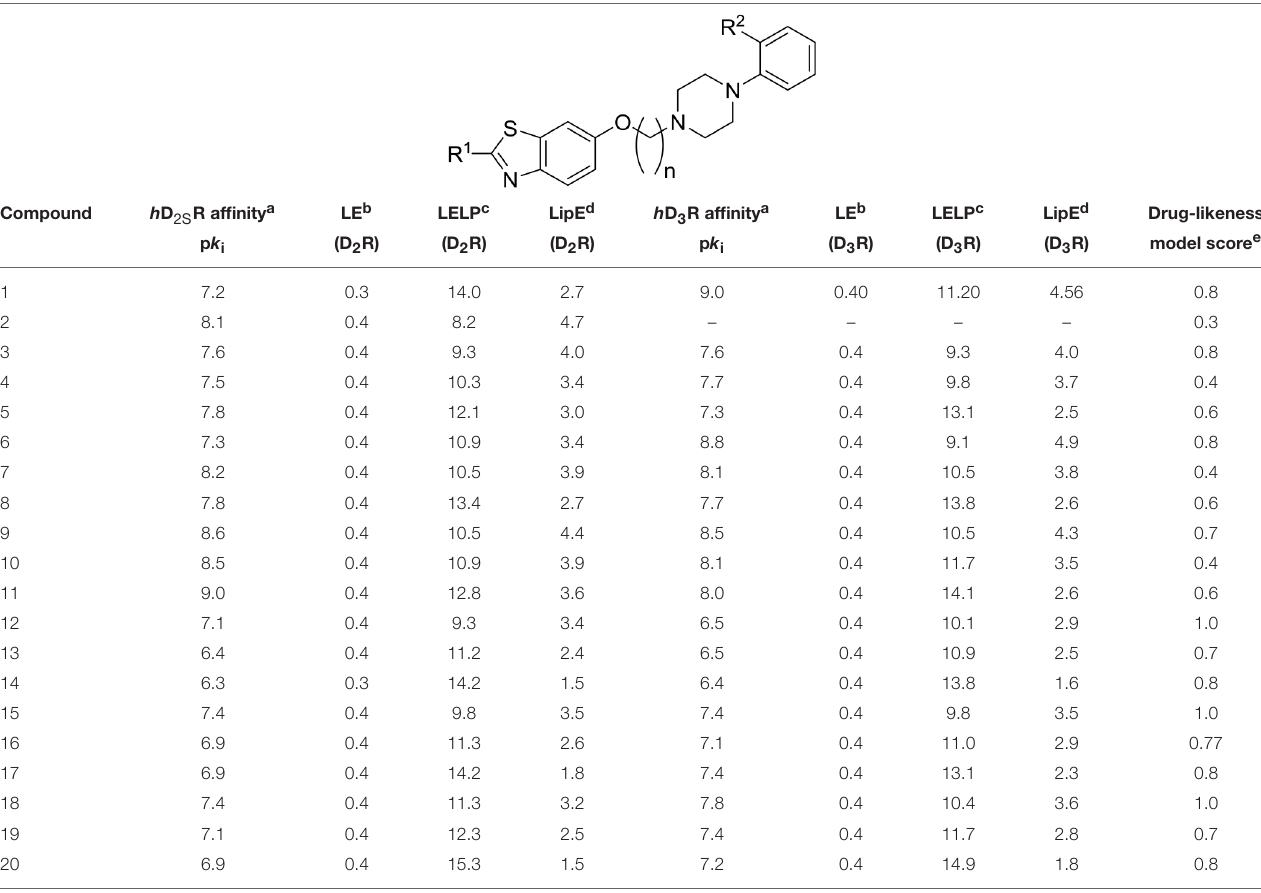
TABLE 3 | Antagonist affinities at h D 2S R and h D 3 R and values of LE, LELP, and LipE for final products 3-20 .